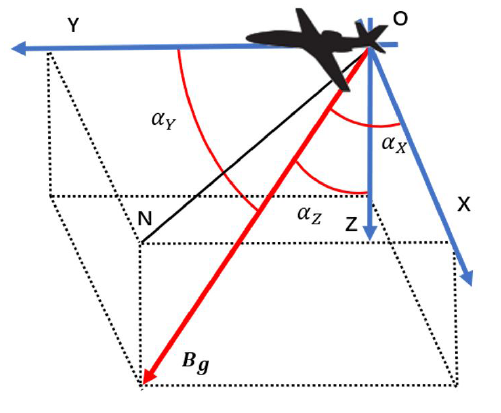
Figure 1. The reference coordinate system defined in this